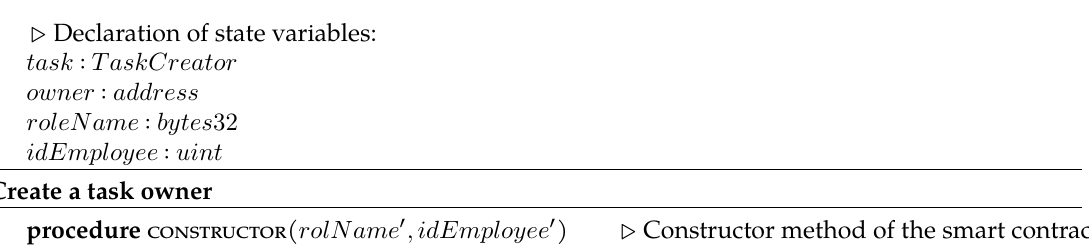
Algorithm 1 Smart Contract: